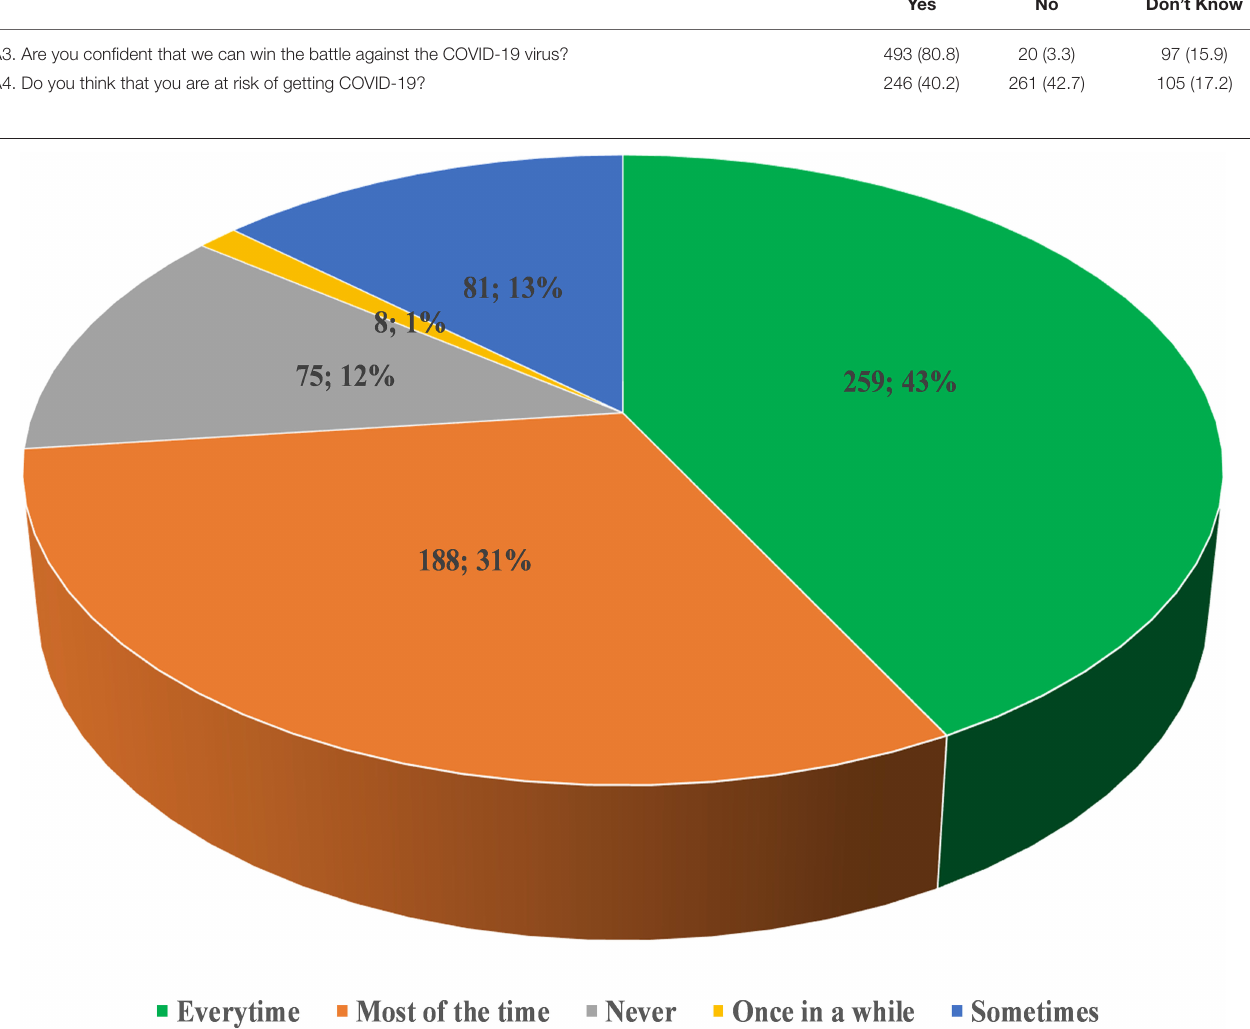
FIGURE 2 | Proportion of the study participants using the “Druk Trace” app while visiting the public place ( n = 613).